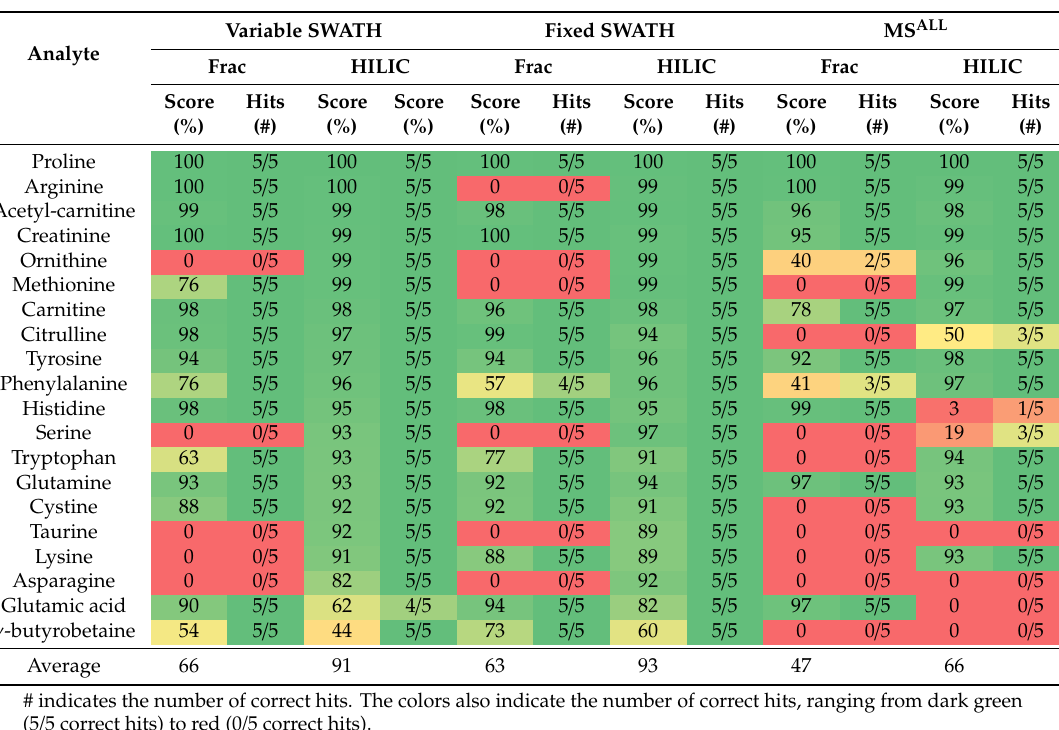
Table 3. Identification of twenty known metabolites using SWATH and MS ALL . The experimental MS / MS spectra were compared with the NIST 2017 library. The mean score of the library hits ( n = 5) and the number of correct hits are listed in the table. MS / MS spectra that could not be matched or resulted in a wrong hit were given a score of 0%.